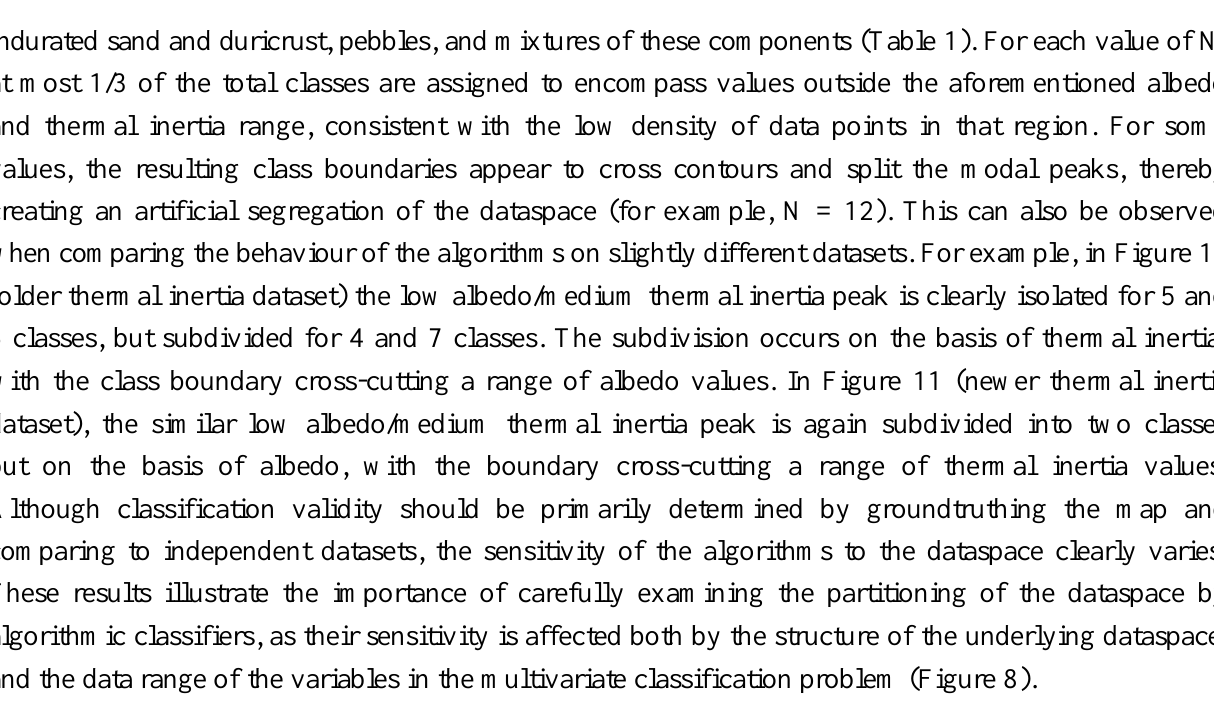
Table 6. Interpretation of thermophysical